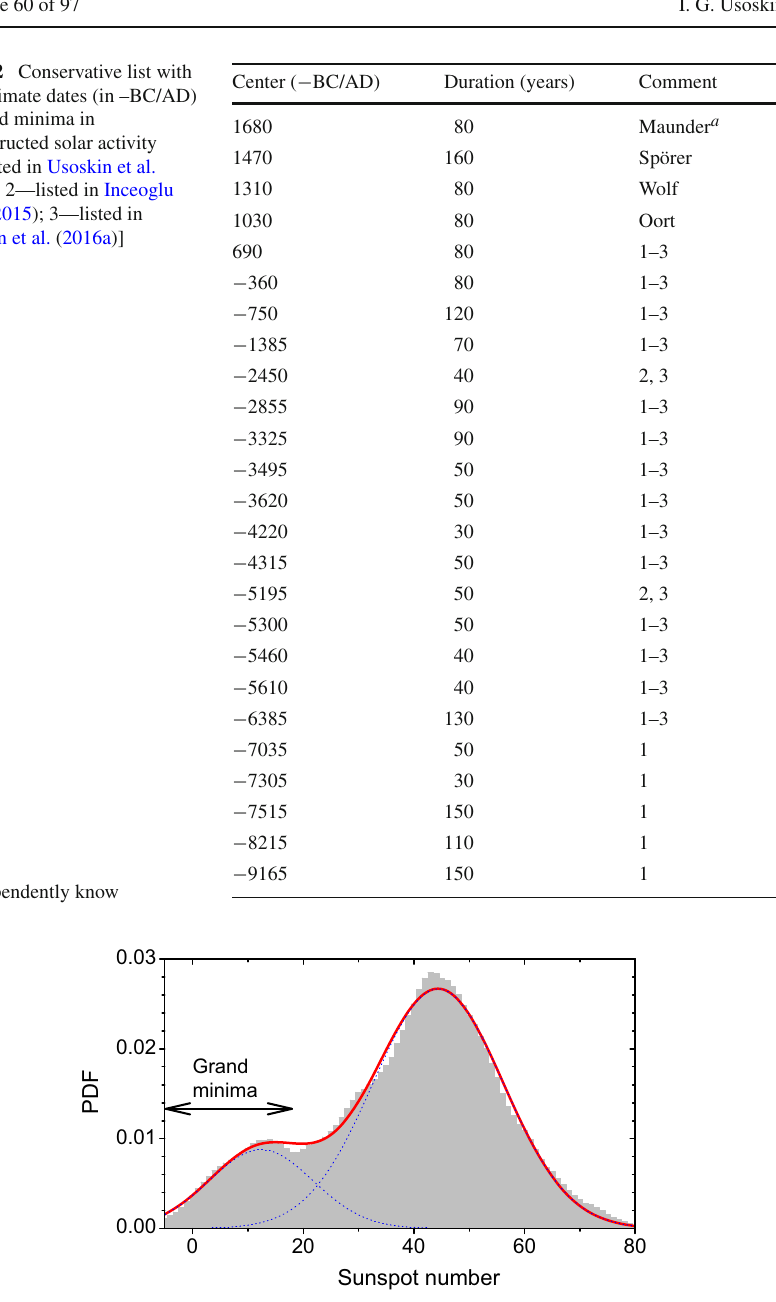
Fig. 21 Probability density function of the reconstructed decadal sunspot numbers for the last three mil- lennia ( grey histogram ). Shown is also the best-fit bimodal Gaussian distribution ( red curve with the two modes shown by dotted blue lines ). The Grand minimum mode is indicated by the arrow . (Modified after Usoskin et al.